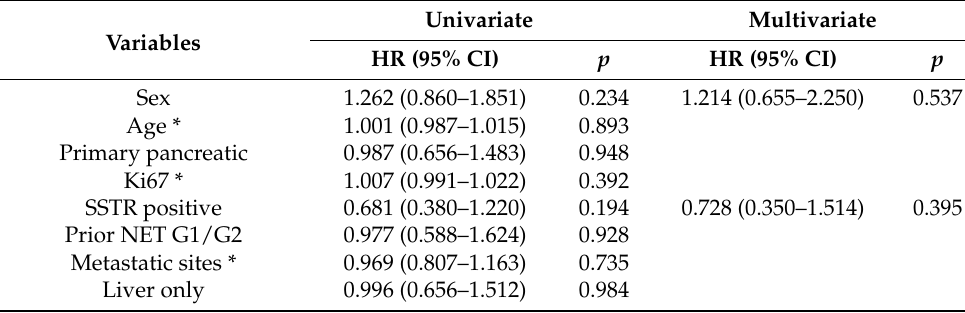
Table 4. Progression-free survival of first-line therapy (univariate, multivariate